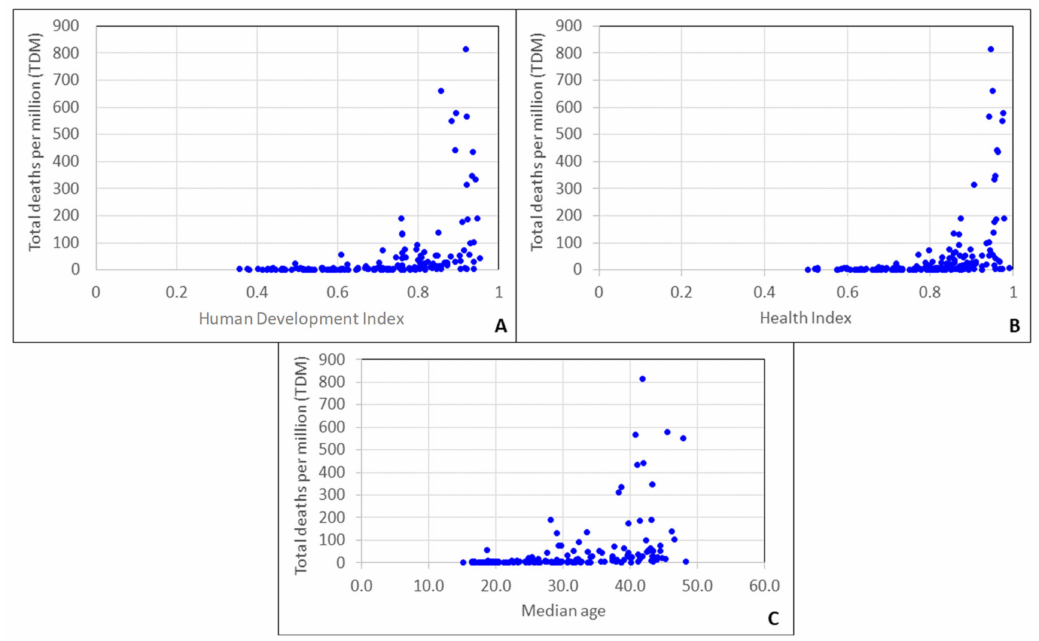
Figure 2. Variation of the total deaths per million for the period of 1 / 3 / 2020–31 / 5 / 2020 with ( A ) Human Development Index, ( B ) health index, and ( C ) median age (data for 167